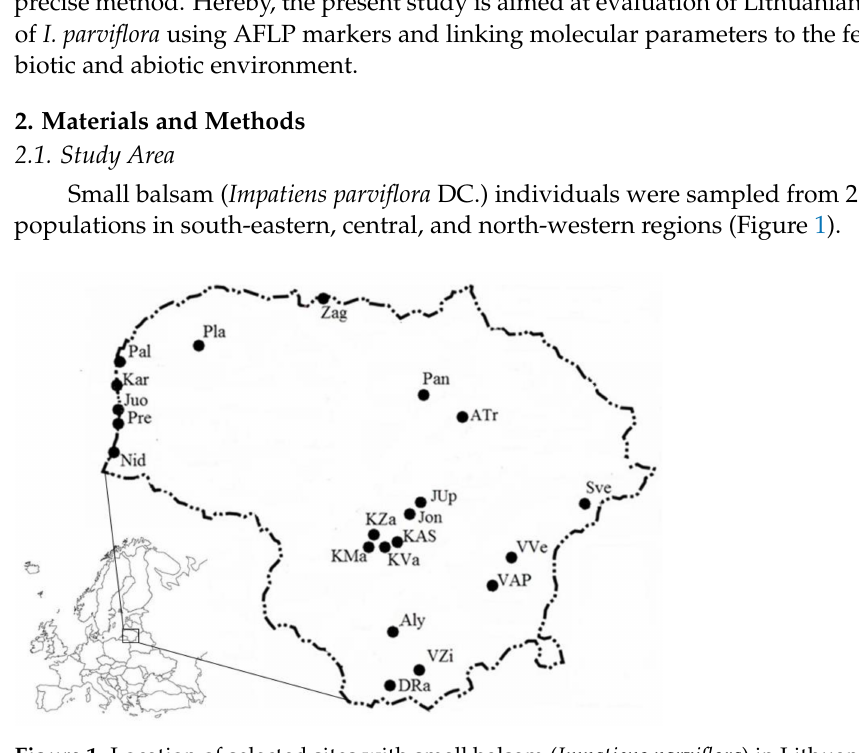
Figure 1. Location of selected sites with small balsam ( Impatiens parviflora ) in Lithuania. The names of populations consist of three letters, which are acronyms of geographical